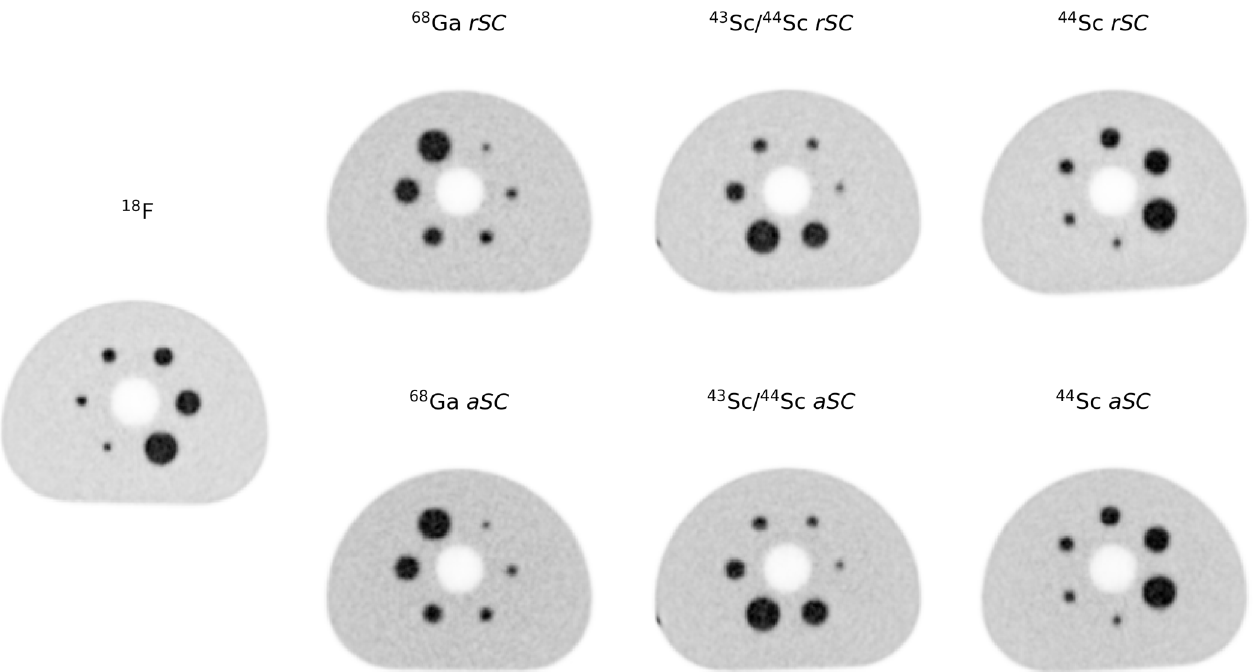
Figure 4. Reconstructions obtained for NEMA phantom. Cross-section images of the phantom using different radionuclides and reconstructions.